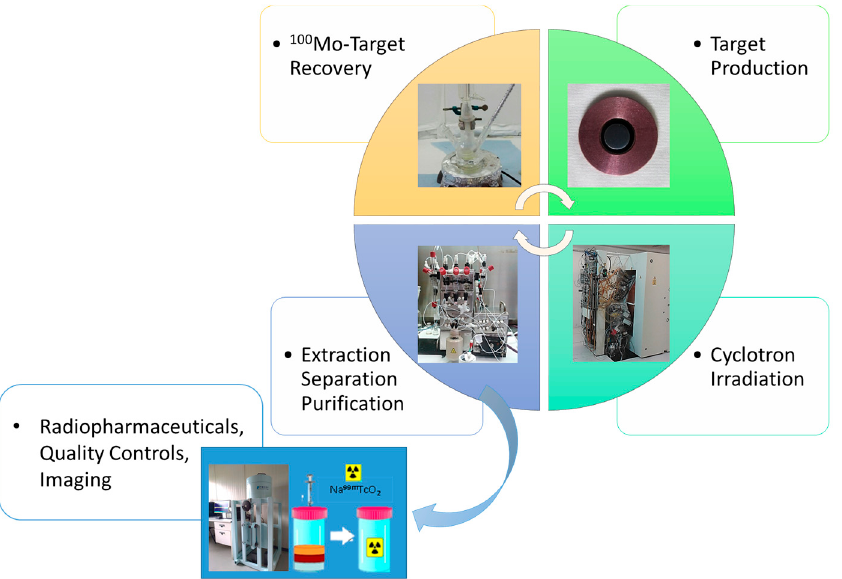
Figure 5. Schematic representation of the tasks accomplished within the APOTEMA and TECHN-OSP projects.